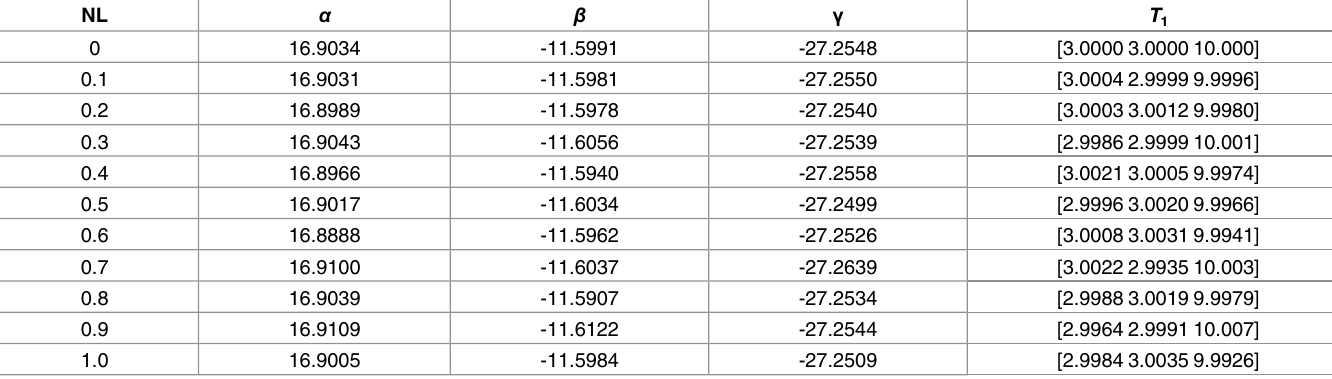
Table 2. Average of extrinsic parameters under different noise